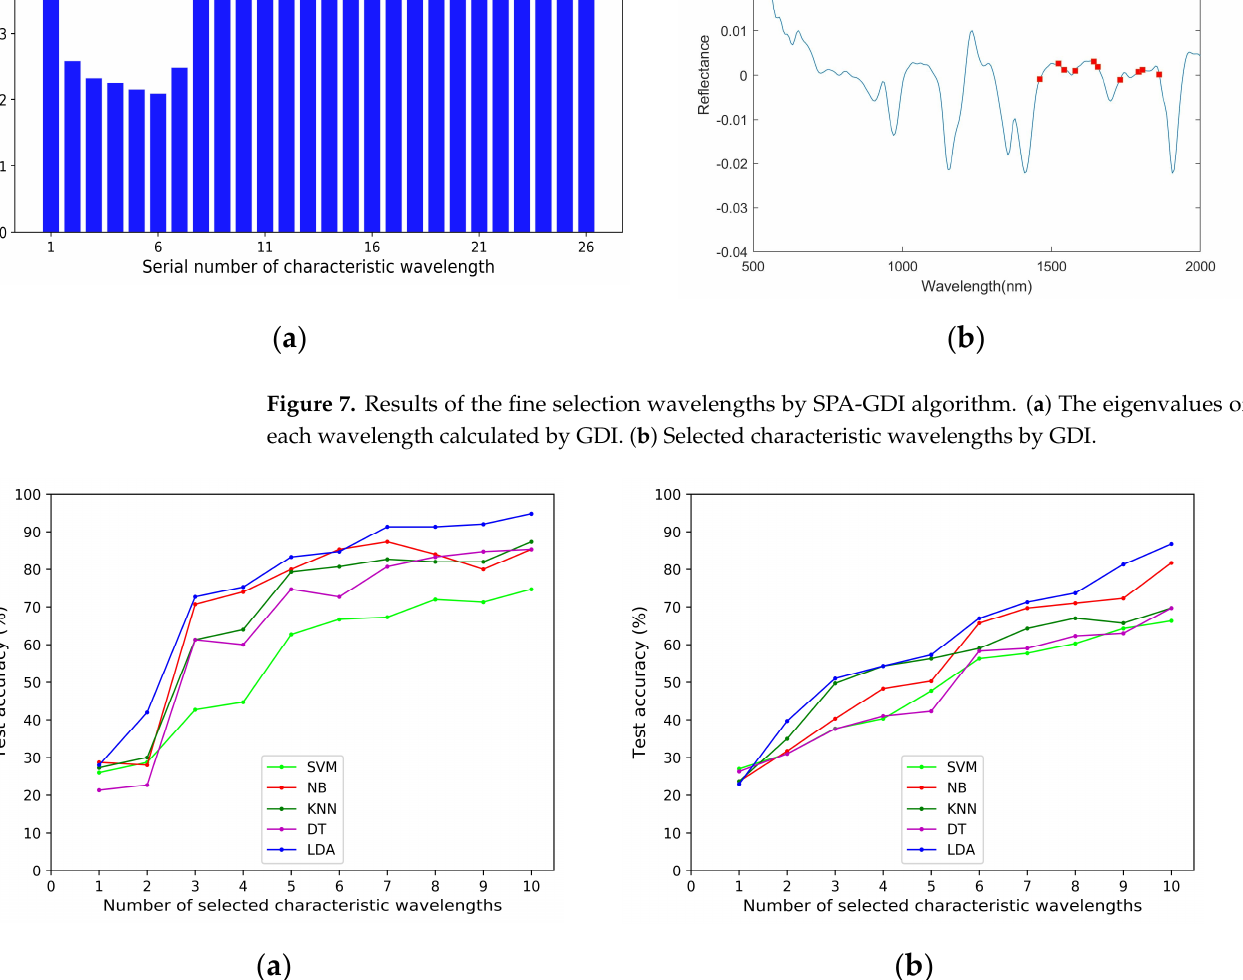
Figure 7. Results of the fine selection wavelengths by SPA-GDI algorithm. ( a ) The eigenvalues of each wavelength calculated by GDI. ( b ) Selected characteristic wavelengths by GDI.